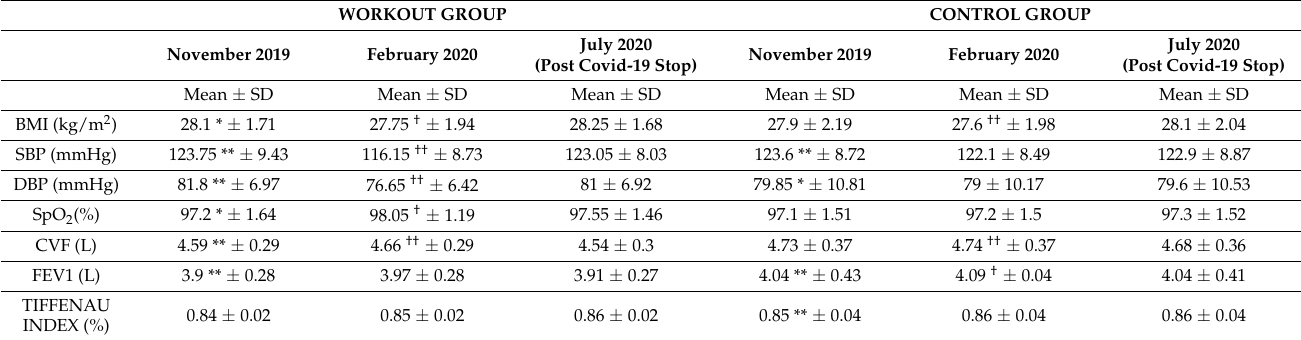
Table 1. Pre and post values for health status variables of workout group and control group shown as mean ± DS. WORKOUT GROUP CONTROL